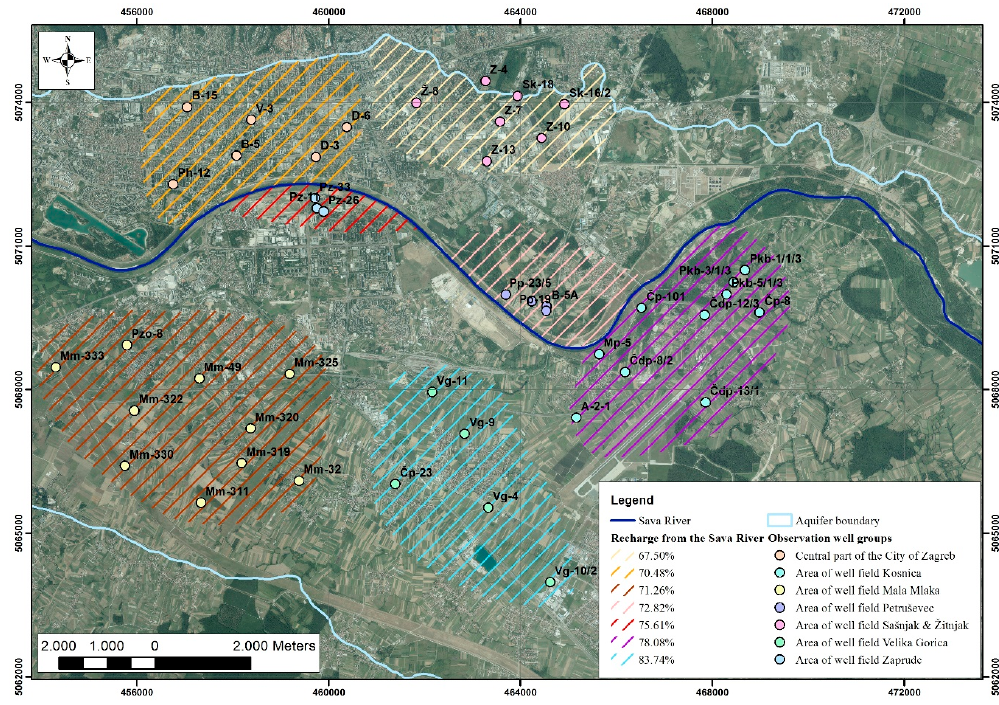
Figure 6. Spatial recharge fractions of the Zagreb aquifer from the Sava River. Table 4. Recharge fractions in the spatially di ff erent areas of the Zagreb aquifer. Recharge from the Recharge from the Sava Grouped Observation Wells Precipitation (%) River (%) Central part of the City of